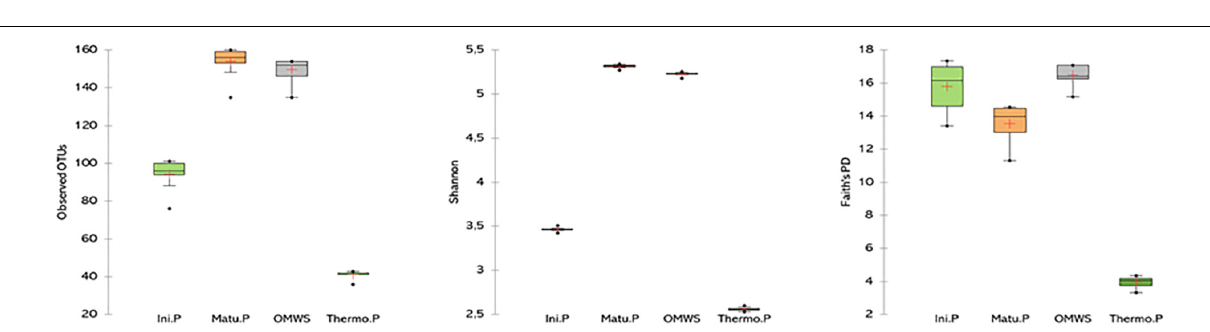
FIGURE 4 | Number of observed OUT’s and distribution of Shannon and Faith’s phylogenetic alpha diversity. Raw olive mill waste sludge (OMWS) Initial phase (Ini.P), Thermophilic phase (Thermo.P) and Maturation phase